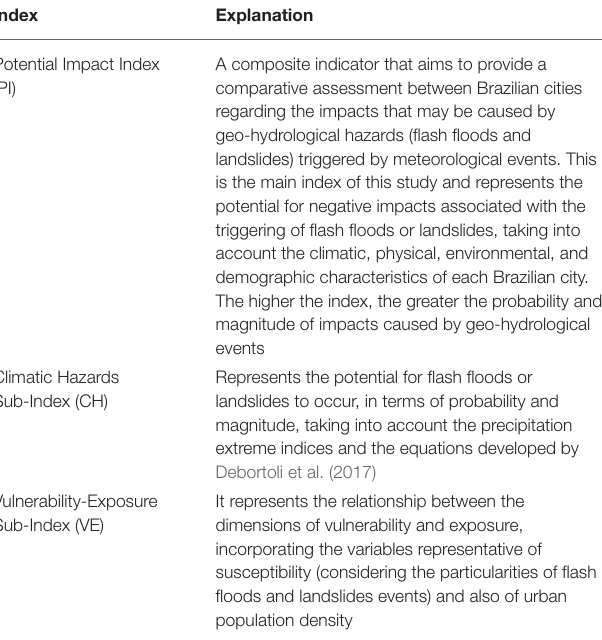
TABLE 2 | Indices used to assess flash floods and landslides (adapted from Debortoli et al.,